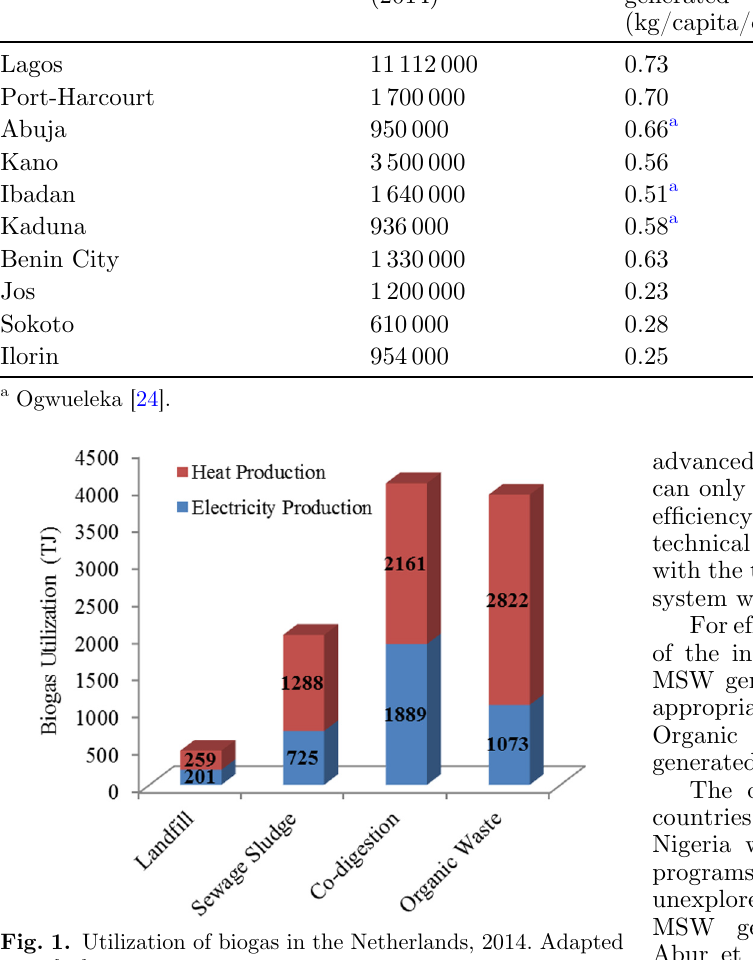
Table 1 of ten selected Nigerian cities, showing population estimate for 2014, as calculated by the author, consistently applying a 2.74% population growth rate to